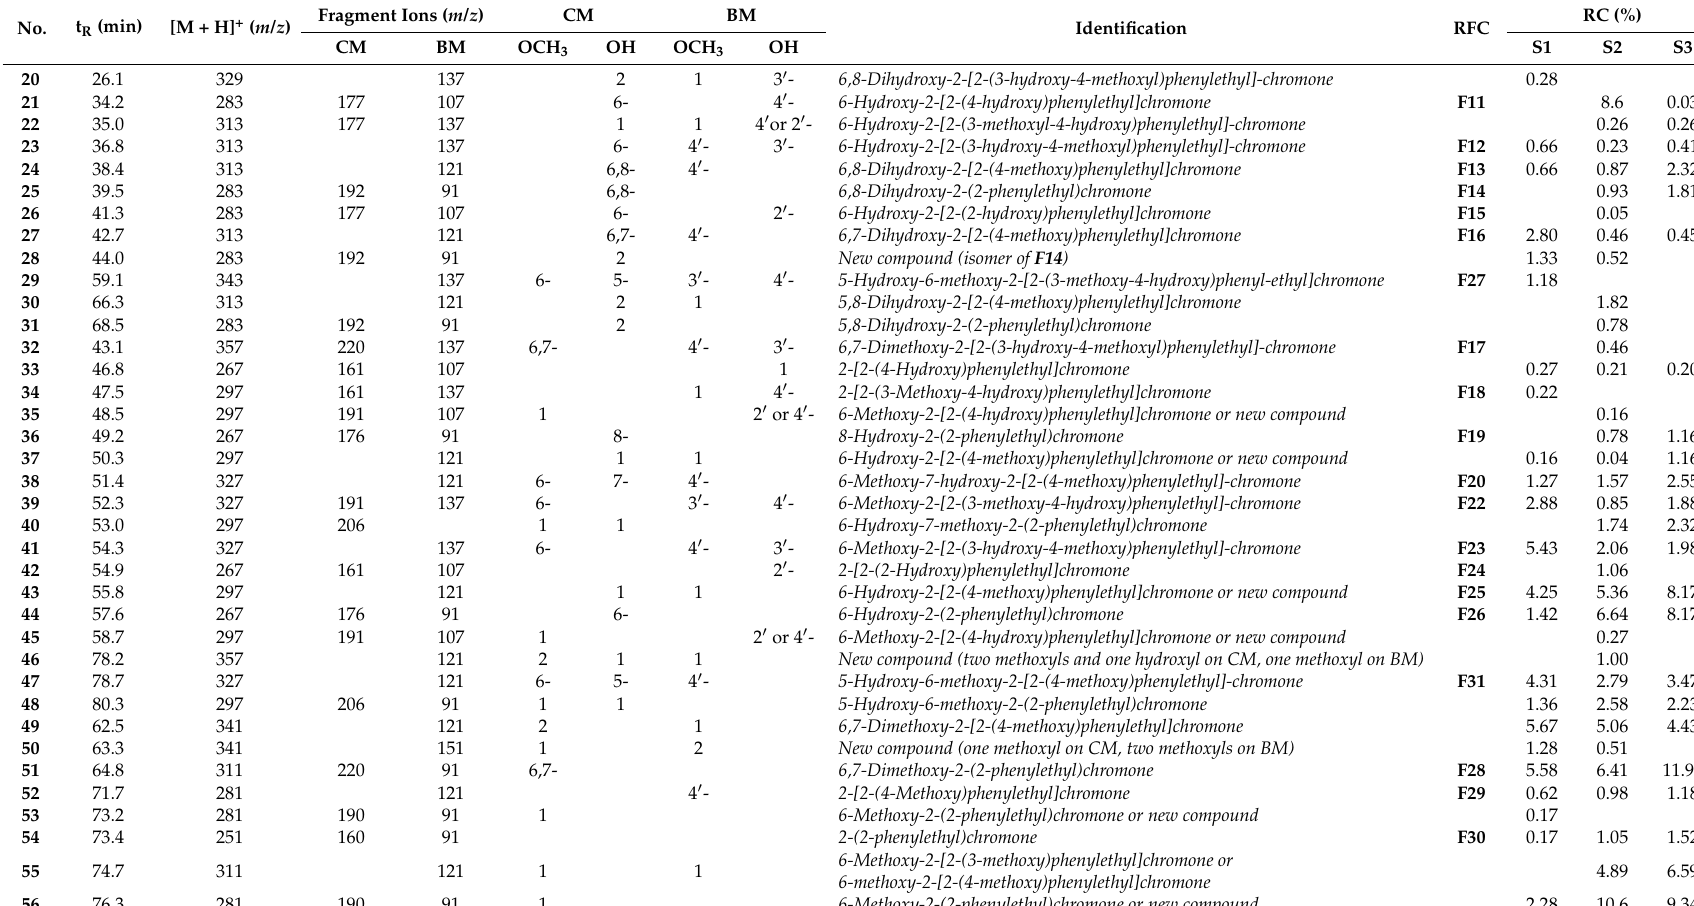
Table 3. The MS characterization and identified or characterized results of FTPECs from S1 to S3 by HPLC/DAD/ESI/MS 2